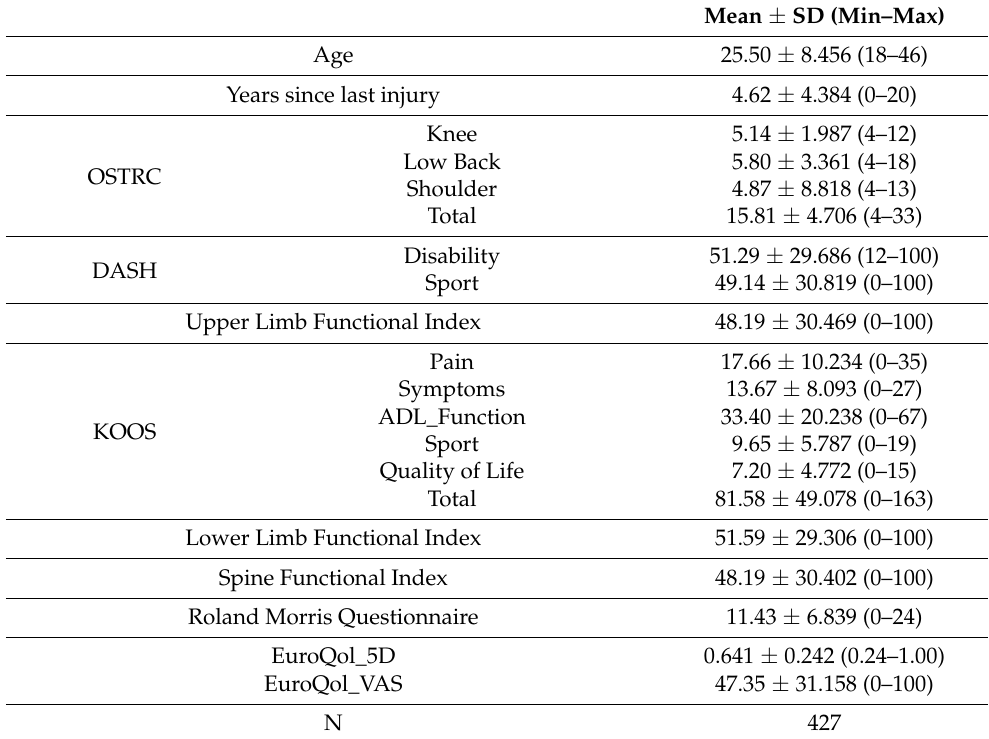
Table 2. Age and descriptive results of all the outcome variables used in this